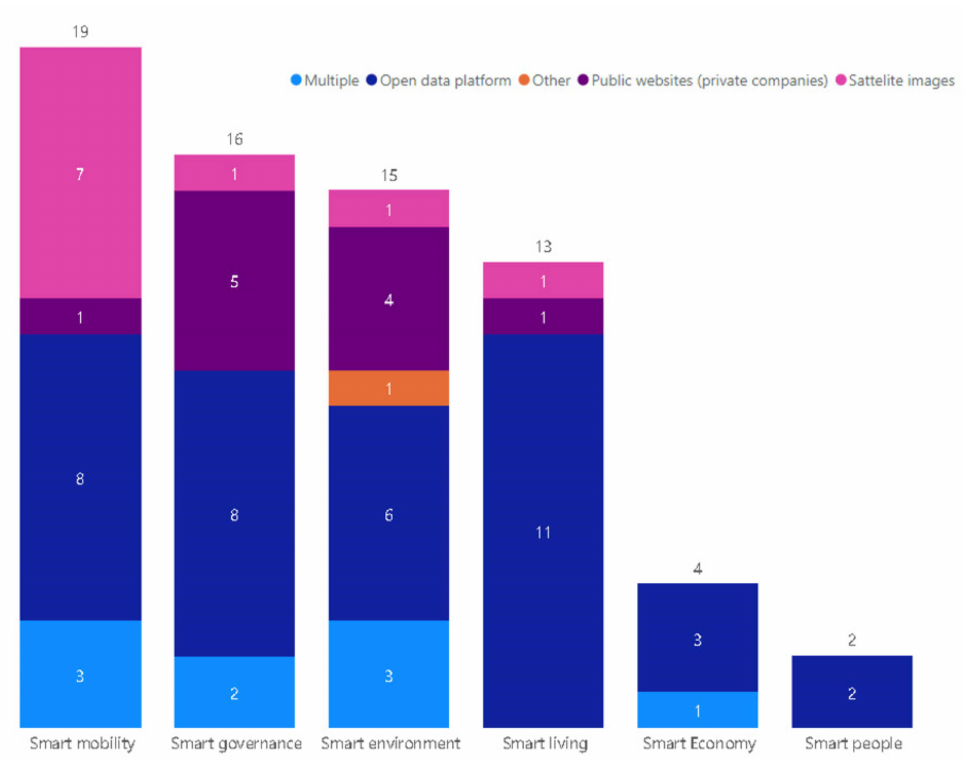
Figure 14. List of papers classified by the sources for open data used in ML